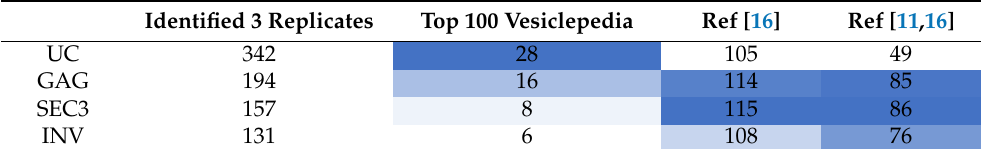
Table 5. Overlap between our study and the Top-100 proteins described in Vesiclepedia, and with previous published proteomics analysis of blood samples. Intensity of the color correlates with the numerical value within columns. To consider a protein identified, at least two peptides should be detected in 3 biological